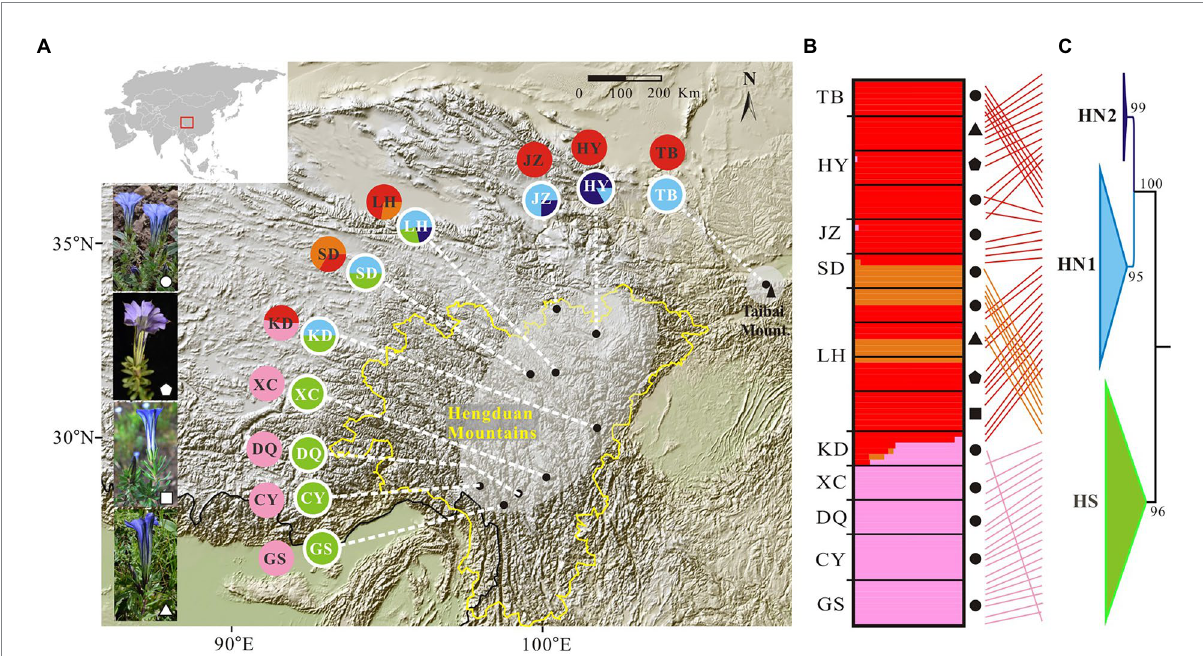
FIGURE 1 Genetic structure in the Gentiana hexaphylla complex. (A) Pie charts showing frequency of plastid haplotypes (inner circles) and colour-coded groups based on 1,907 SNPs in FastStructure (outer circles) for each sampling site. Black dots represent sampling sites. Map came from the Institute for Planets. (B) Bar plots showing probabilities of ancestral clusters of each sample at K = 3 in FastSTRUCTURE. The sampling site is shown on the left of the bar plot. Dark shapes in panels B , C indicate different species: circles, G. hexaphylla ; pentagons, G. viatrix ; squares, G. tetraphylla ; triangles, and G. ternifolia . (C) Phylogeny of plastid data based on eight plastome fragments. Support values from the maximum likelihood analyses are shown on the nodes. Subclades are named HN1, HN2, and HS. Line connections indicate the same individual in the phylogeny and bar plot. The border of the Hengduan Mountains is indicated with a broken yellow line, and based on Ding et al. (2020). An equal-area projection has been used in the map. White shapes in the photos indicate different species, as used in panels B , C . Photographs: Peng-Cheng